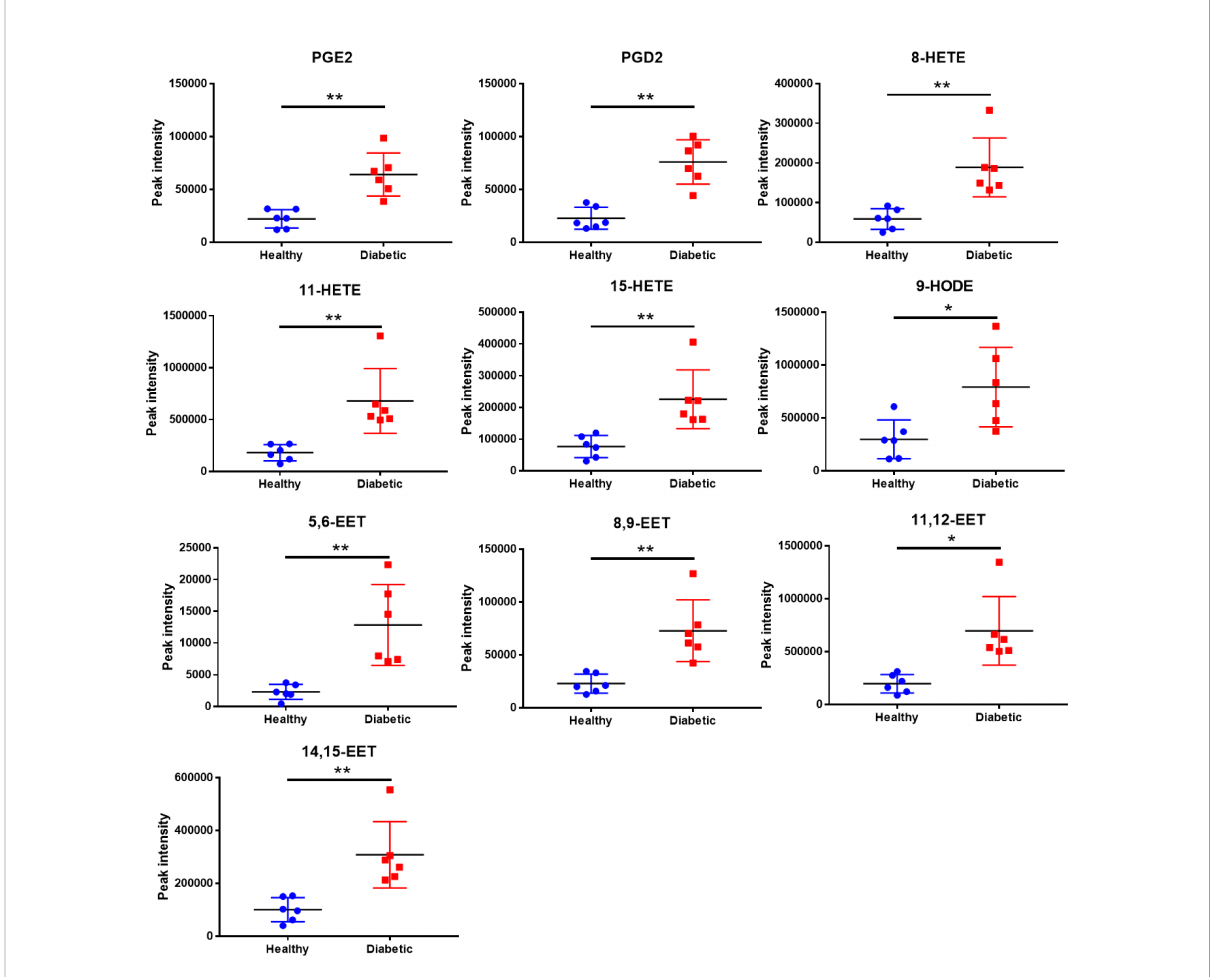
FIGURE 3 Quantitative comparison of oxidized fatty acids that signi fi cantly changed between the diabetic and healthy groups. ** p < 0.01, * p < 0.05. p values were obtained from analysis of paired Student ’ s t